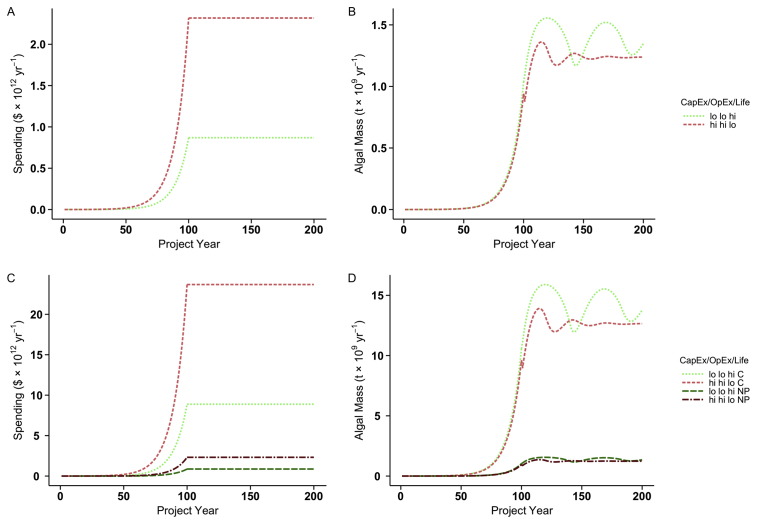
Gross expense and biomass production for recycling N/P and C. Two scenarios are illustrated: High CapEx/OpEx with a 20 year floway life expectancy (worst case; “hi hi lo”), and low CapEx/OpEx with a 40 year floway life expectancy (best case; “lo lo hi”). (A) Best and worst cases for N/P recycling eventually require spending $8.7 × 1011 and $2.3 × 1012 annually, respectively. (B) N/P recycling produces 1.2 × 109 t yr−1 algal biomass. (C) Best and worst cases for C recycling require eventually spending $8.9 × 1012 yr−1 and $2.4 × 1013 yr−1, respectively. (D) C recycling produces, 2.2 × 1010 t yr−1 algal biomass. (C and D) N and P recycling included for scale.